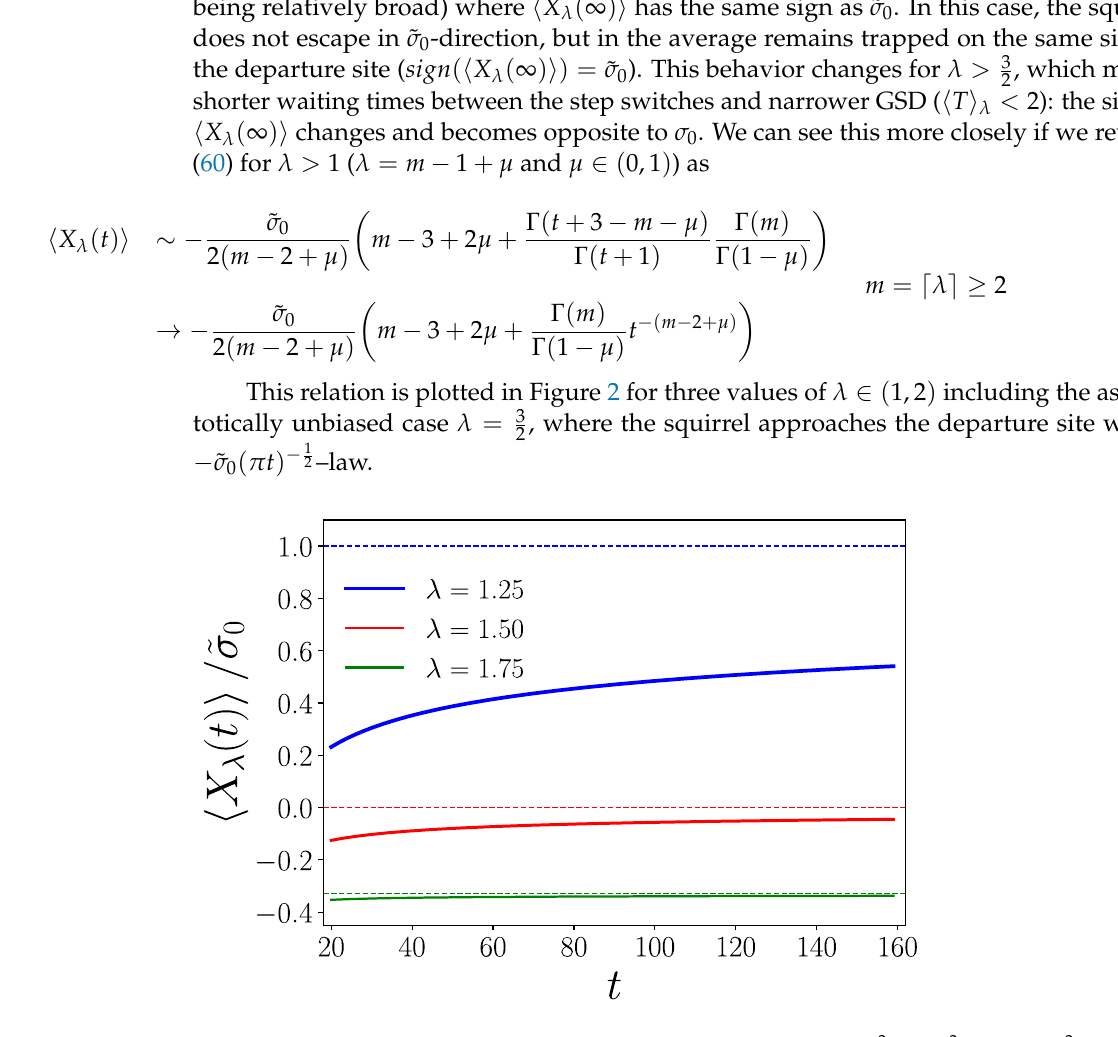
, λ = 3 , and λ > 3 . The case 2 2 2 ( ∞ ) (cid:105) = 0. Dashed lines 2